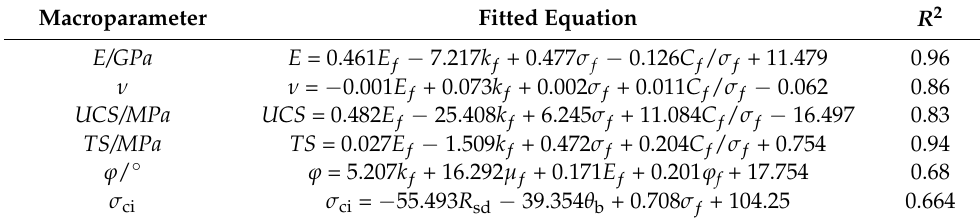
Table 4. Fitted equation.